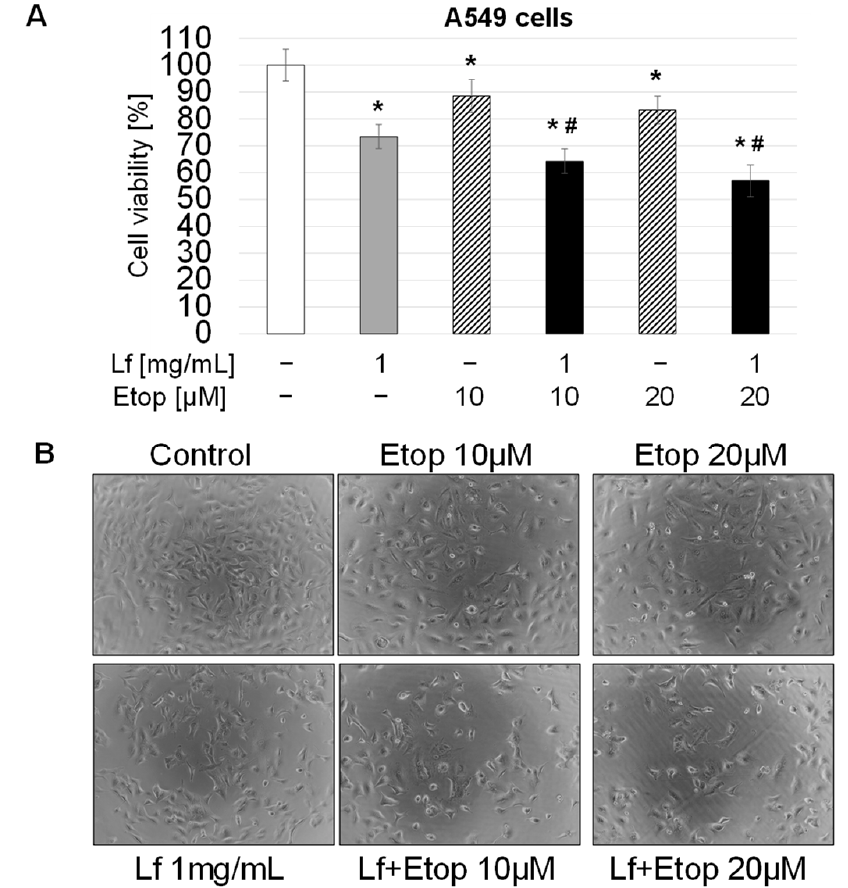
Figure 2. Effect of rhLf in combination with etoposide on A549 cell growth. ( A ) A549 cells were cultured in the presence of rhLf (Lf) and etoposide (Etop) alone or in the combination of both at indicated concentrations for 24 h and viable cells were quantified by a WST assay. The results were calculated as a percentage of control cells and expressed as the mean ± SD of three experiments performed in duplicate. ( B ) Visualization of the effect of rhLf, etoposide alone or the combination on cancer cell growth and cell morphology. Representative phase-contrast cell images are shown after 24 h treatment (100 × magnification). * p < 0.05 compared to the control. # p < 0.05 compared to etoposide alone at the same concentration.